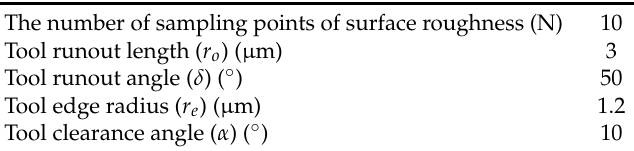
Table 2. Machining